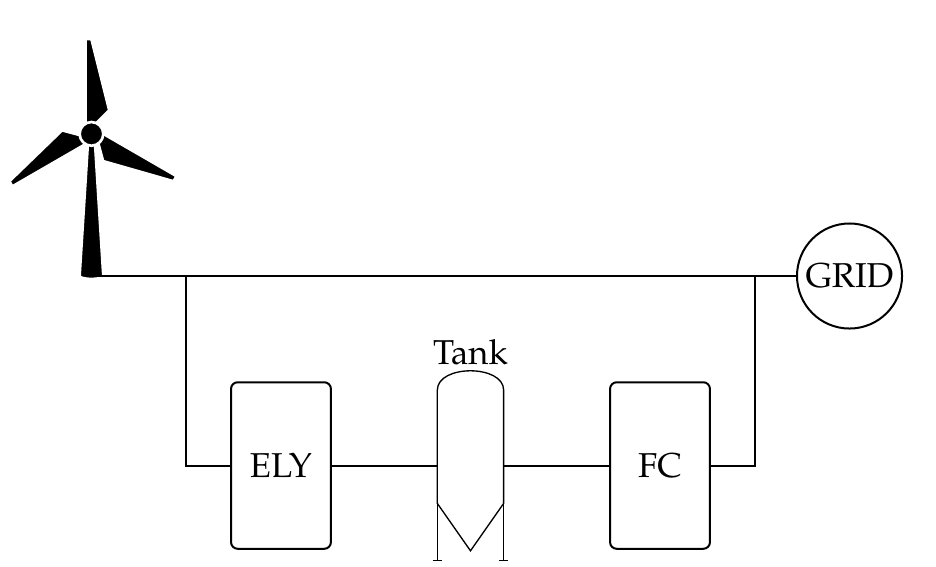
Figure 2. Simplified sketch of the addressed scenario. ELY stands for “electrolyzer” and FC stands for “fuel cell”.